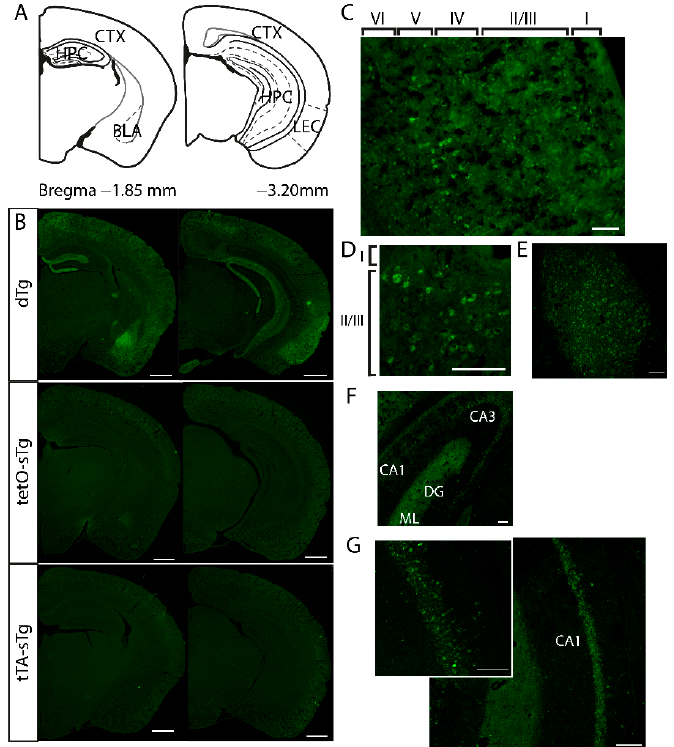
Figure 1. The basal expression of mPAK3-GFP proteins in sTg and dTg animals. ( A ) Schematic of the regions of interest in dorsal and posterior coronal sections. ( B ) The global expression of mPAK3-GFP proteins in dorsal and posterior coronal half brain sections from dTg and control, tetO-sTg, and tTA-sTg mice. Scale bar = 1000 µ m. ( C – G ) Higher magnifications of the regions of interest in dTg mice. Expression of mPAK3-GFP proteins can be seen in ( C ) all cortical layers, including the ( D ) LEC, as well as the ( E ) BLA, and ( F ) hippocampal CA3 and ( G ) CA1 regions. Scale bars: 100 µ m. CTX, cortex; HPC, hippocampus; BLA, basolateral amygdala; LEC, lateral entorhinal cortex; dTg, double transgenic; tetO-sTg, tetO-mPAK3-GFP single transgenic; tTA-sTg, Fos-tTA single transgenic; CA1, cornus ammonis 1; CA3, cornus ammonis 3; DG, dentate gyrus; ML, molecular layer; GCL, granule cell